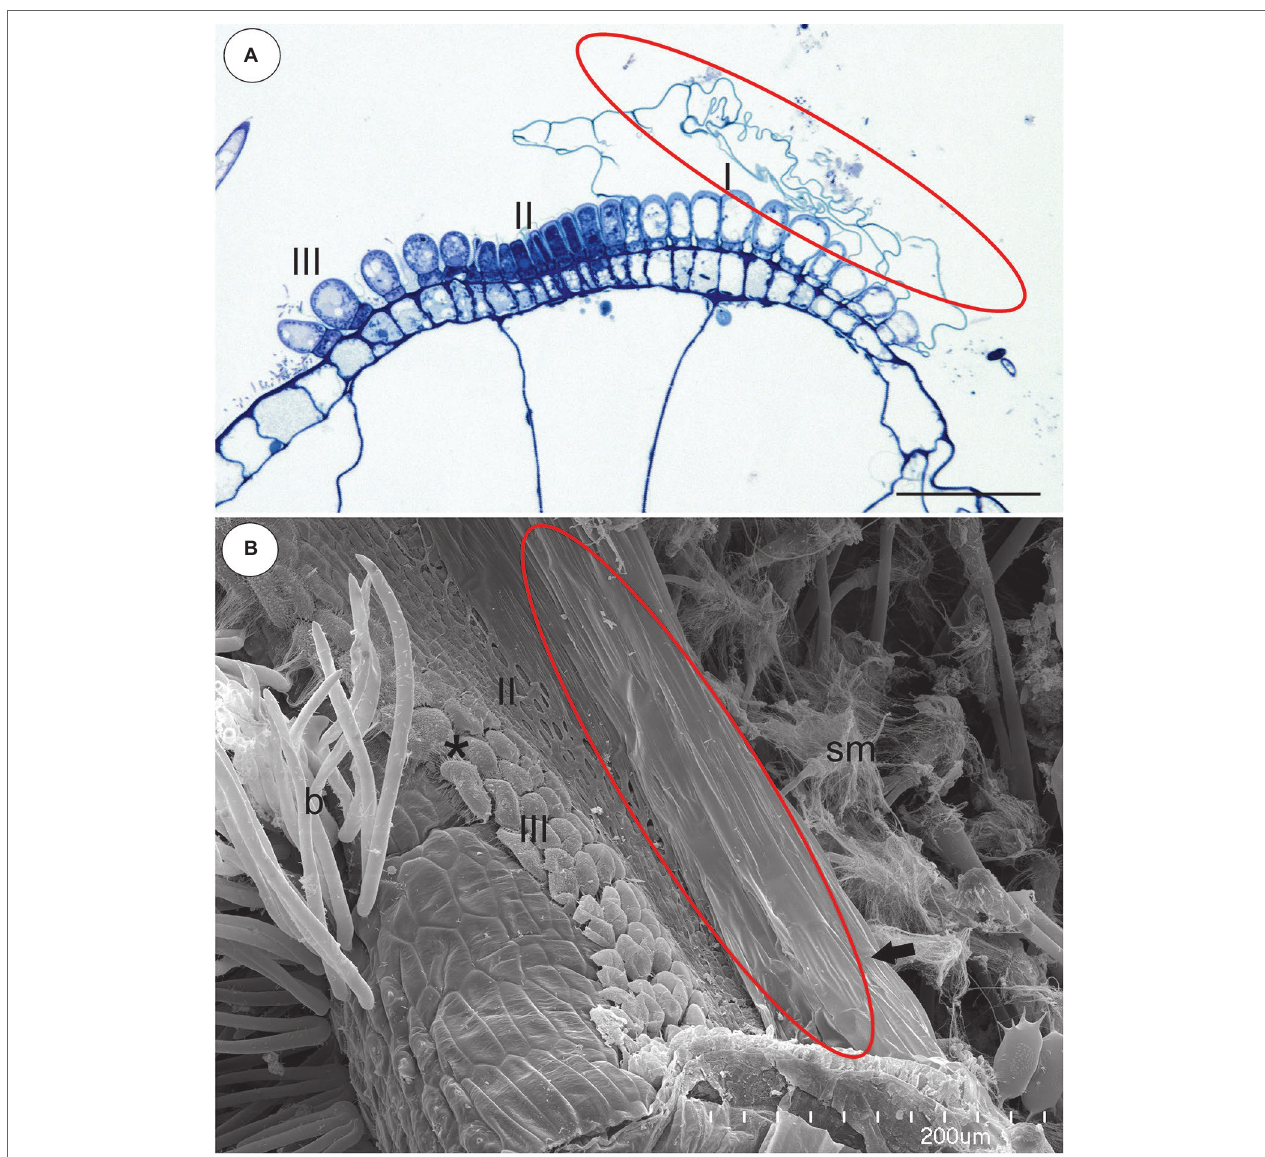
FIGURE 7 | Structure of the pavement epithelium and velum of Utricularia reflexa . (A) A semi-thin longitudinal section of the pavement epithelium, note all of the zones of the pavement epithelium (I, II, III), the velum (ellipse); scale bar = 50 μ m. (B) A SEM image of the pavement epithelium, note the velum (ellipse), the middle zone (II) and the internal zone (III) with the mucilage trichomes (asterisk) and the stalked mucilage trichomes at the front of the pavement epithelium (sm), bifids (b); scale bar = 200 μ